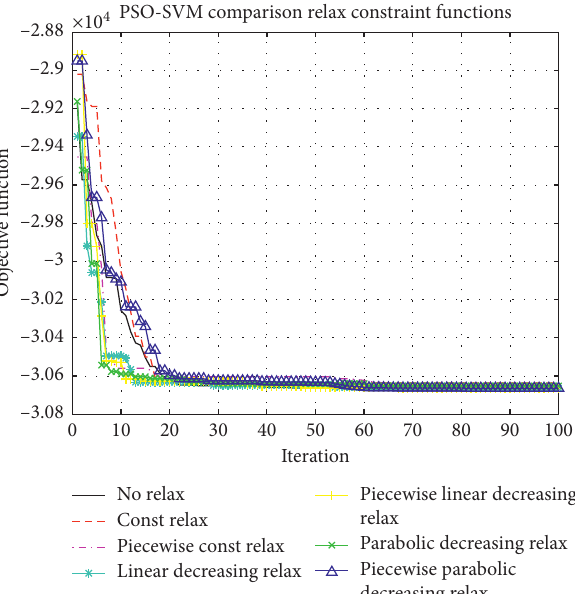
Figure 4: Numerical example 2: objective value history comparison among different relax constraint functions for a single